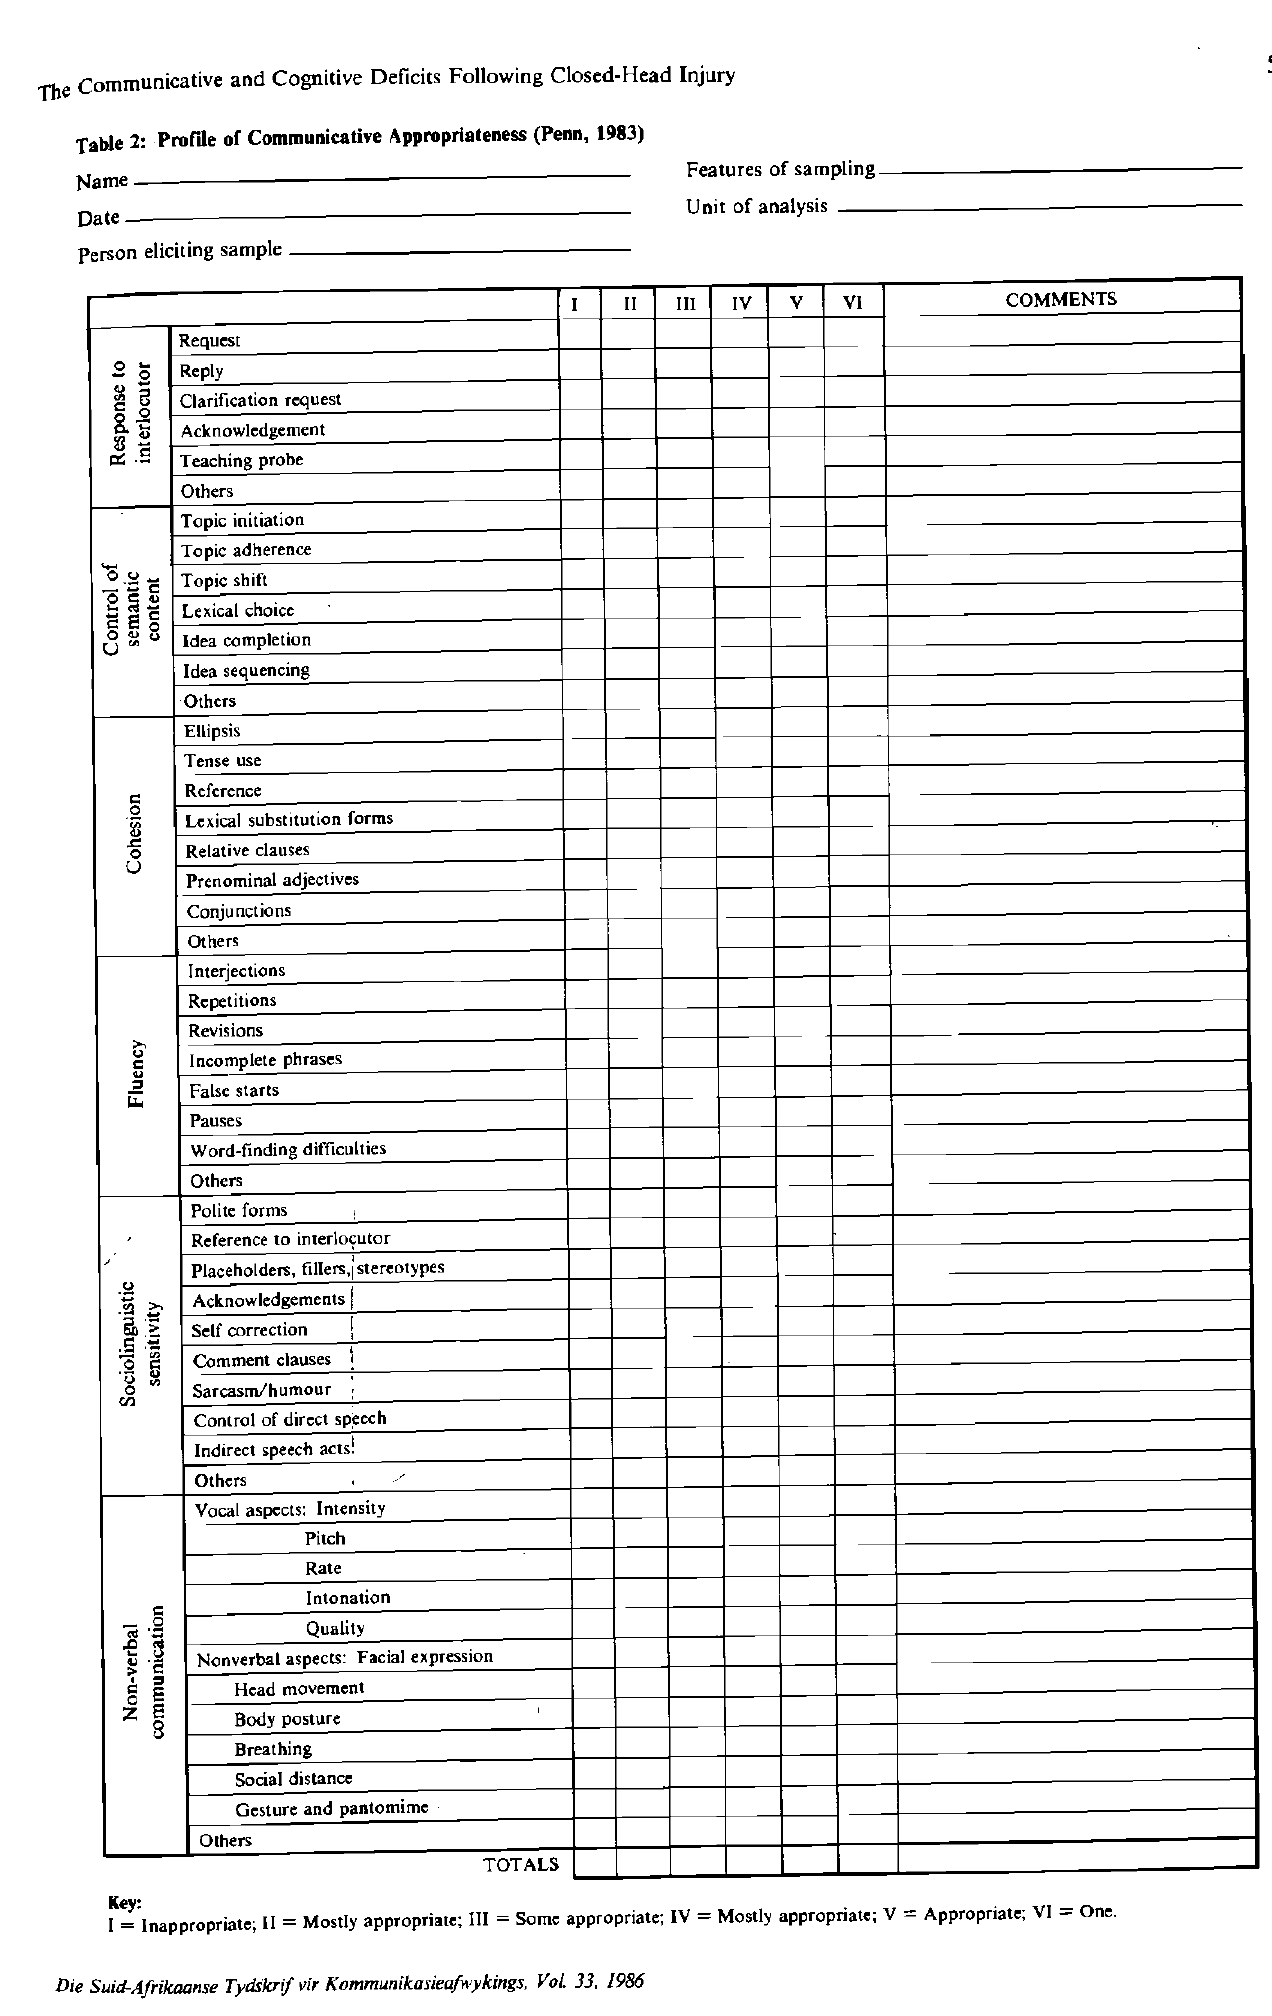
Table 2: Profile of Communicative Appropriateness (Penn, 1983)